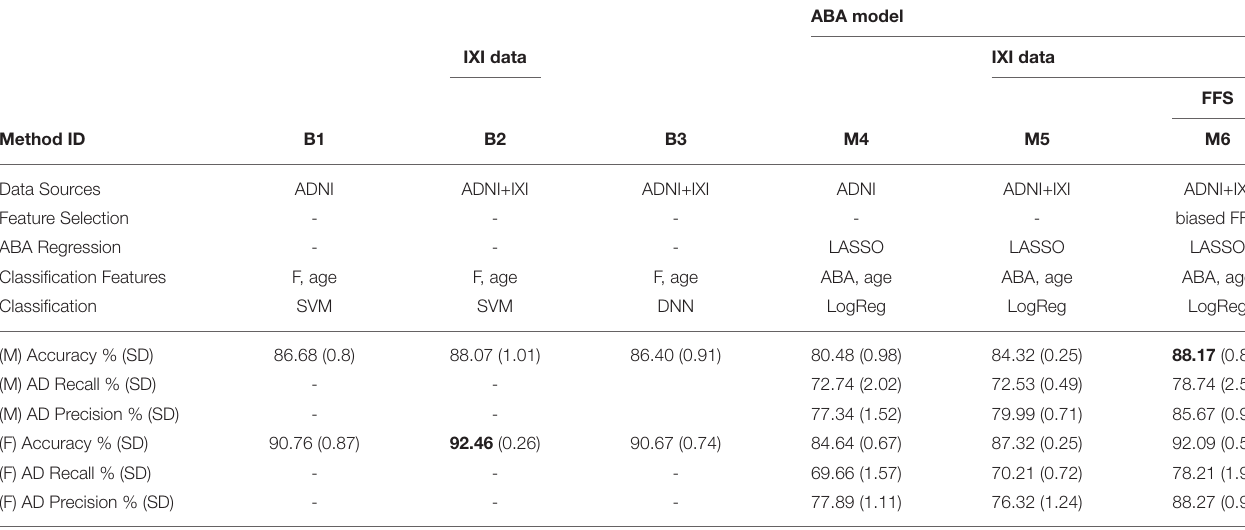
TABLE 3 | Summary of classification results for both gender groups: three baseline methods (B1, B2, B3) vs. the proposed approach (M6) with different configurations (M4, M5) to highlight the contribution of different components.